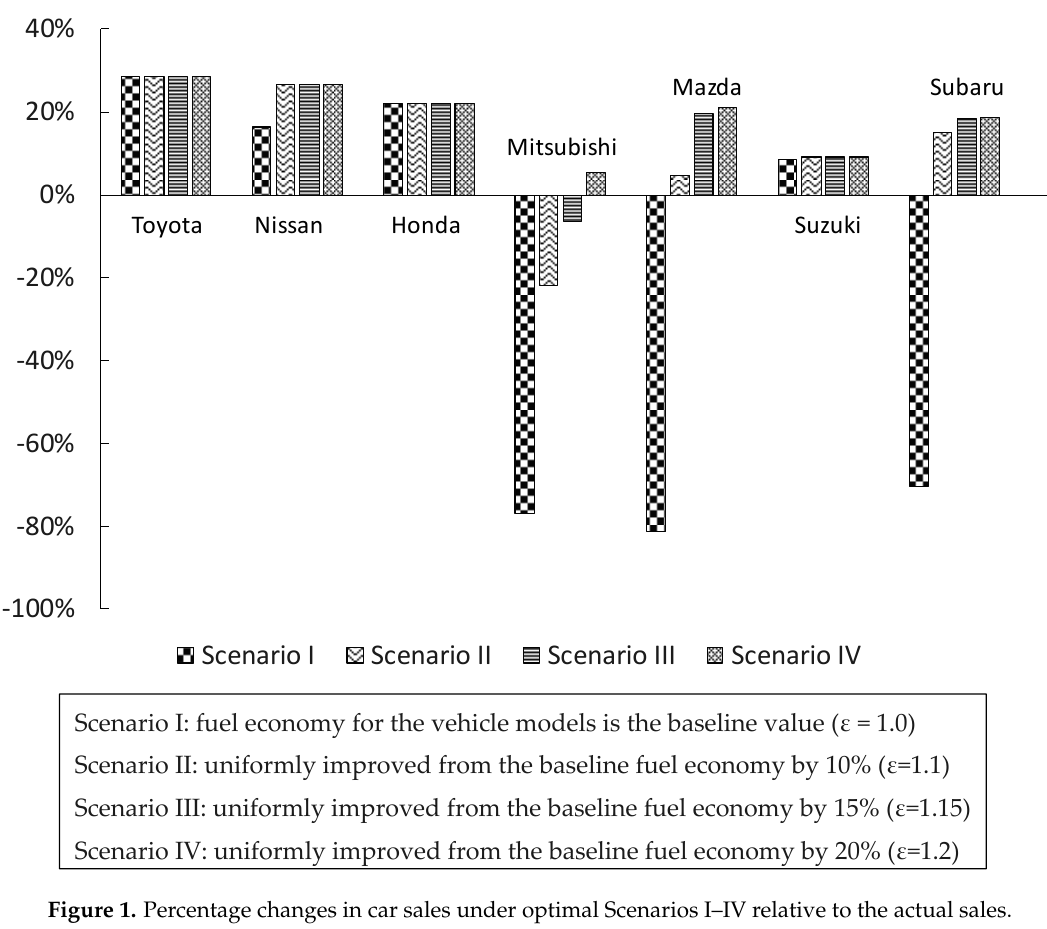
Figure 1. Percentage changes in car sales under optimal Scenarios I–IV relative to the actual sales.